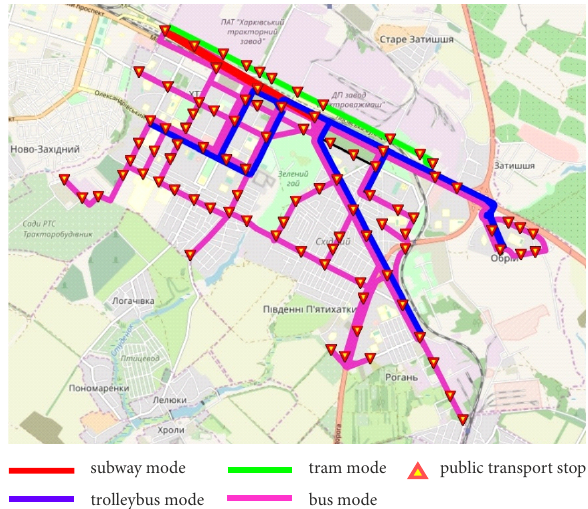
Figure 3. The current public transport network of the Industrial District